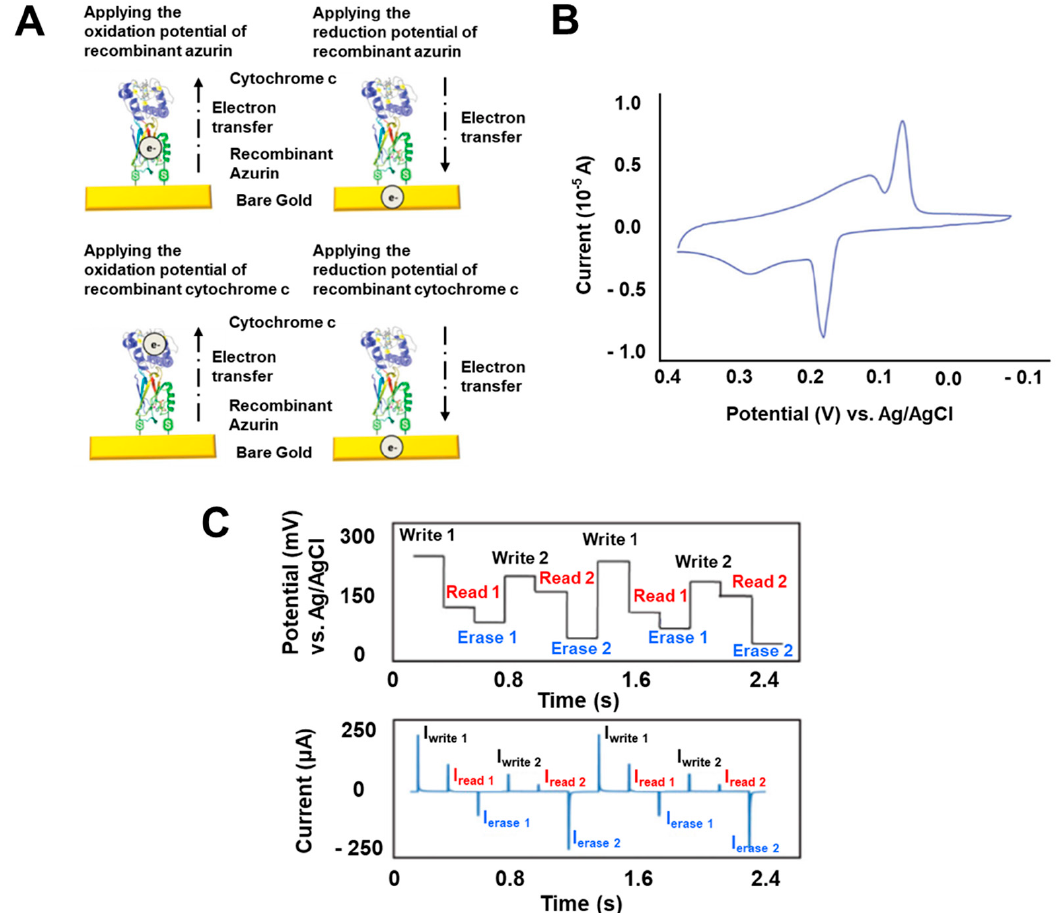
Figure 2. Multilevel biomemory device. ( A ) Schematic image demonstrating a multilevel biomemory device using metal ions states to control two di ff erent kinds of metalloprotein. ( B ) Cyclic voltammogram of a multilevel biomemory device composed of recombinant azurin and cytochrome c that shows two apparently distinguished reduction potential peaks and two oxidation potential peaks. ( C ) Memory performance of a multilevel biomemory device including writing, reading, and erasing steps by applying the potential values of reduction and oxidation potential peak values and the OCP values